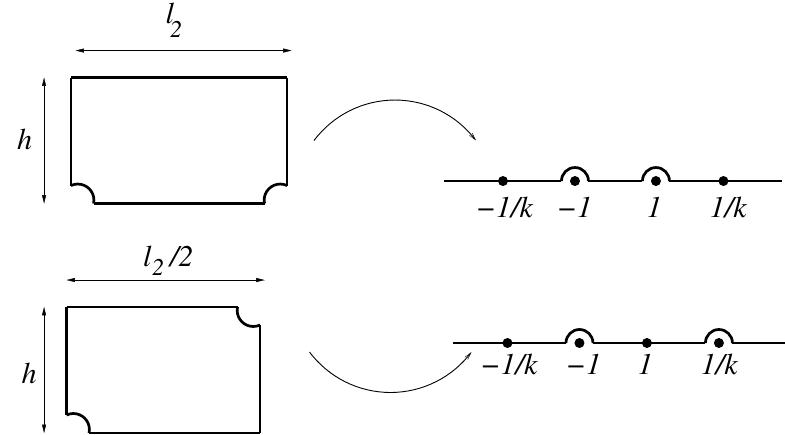
Figure A6. Schematic picture of the Schwarz–Christoffel transformation to obtain the elastic contribution to the free energy of the F a state (upper rectangle) and the F s state (lower